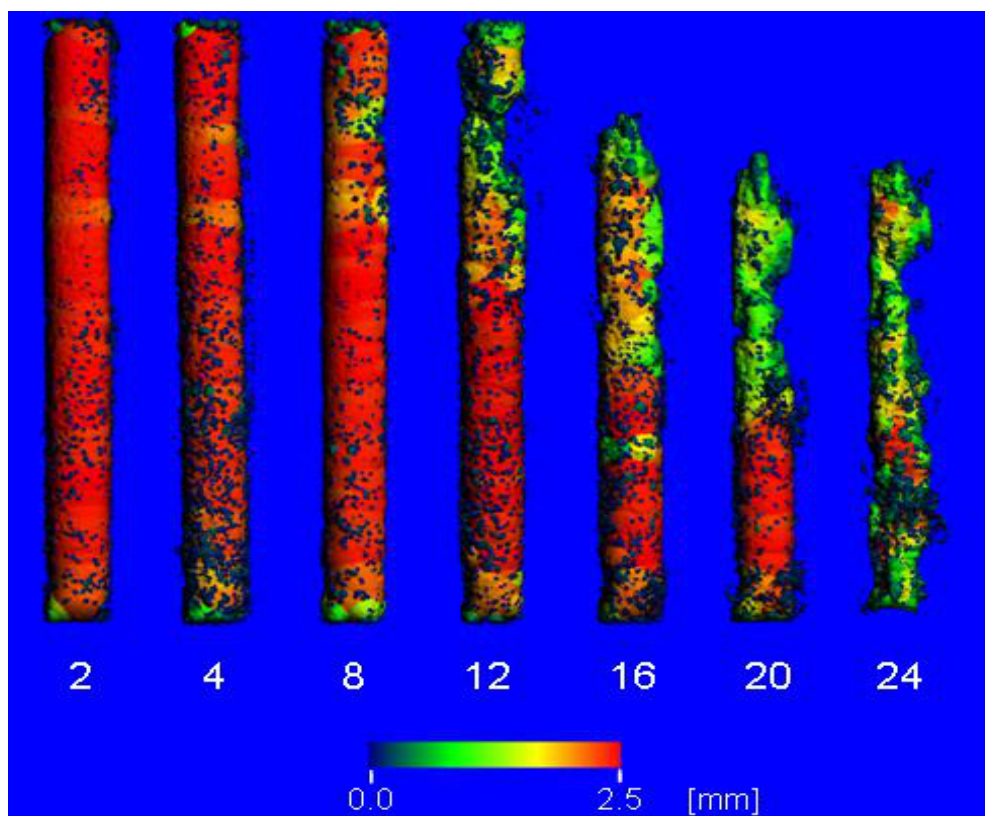
Figure 3. Color mapping of the direct 3D thickness from µCT scans of an exemplary ZEK100 6 months implant. Numbers indicate the respective weeks after implantation.